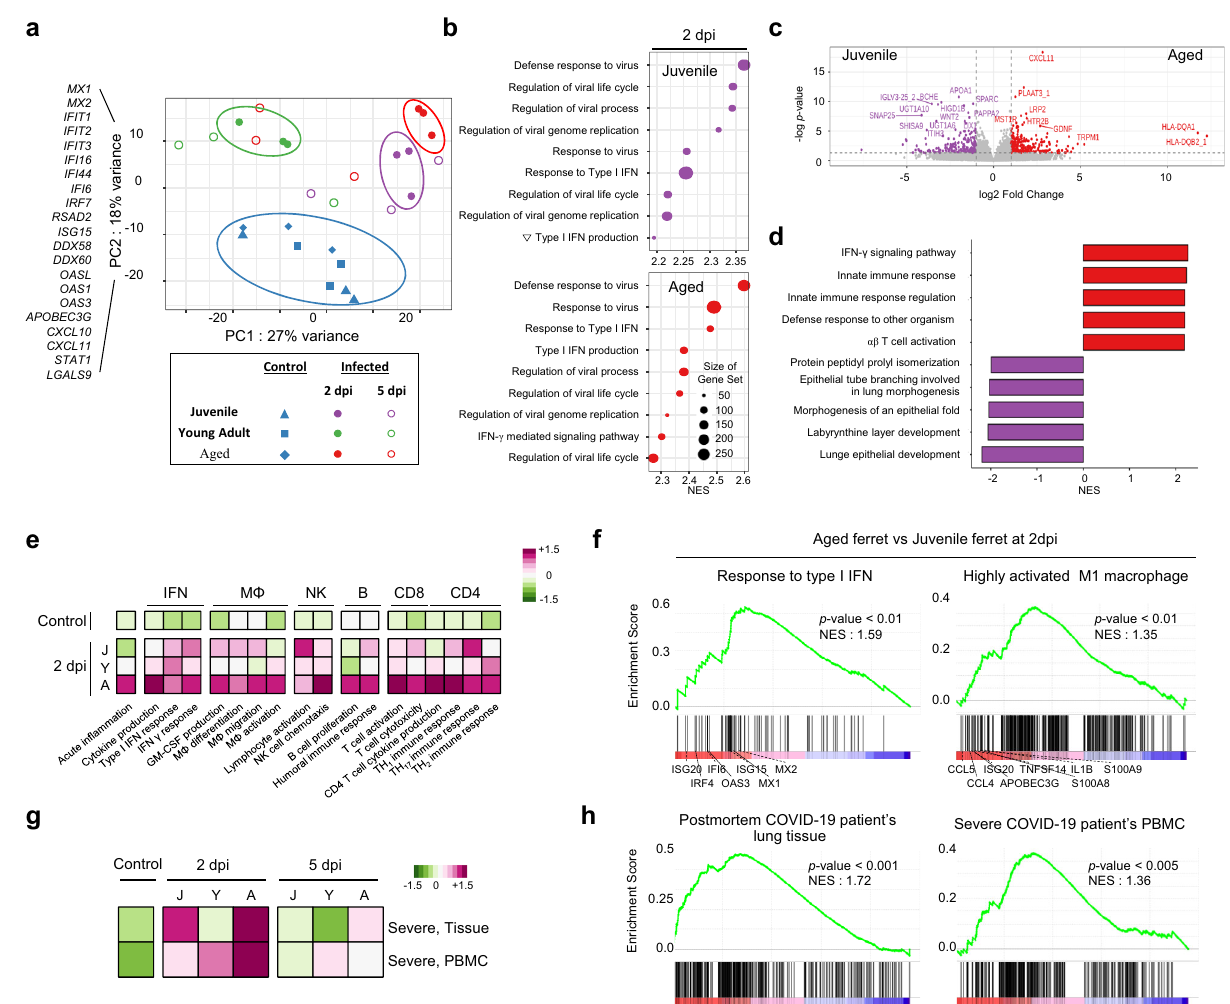
Fig. 6 Transcriptional pro fi le of immune-related genes in the lung of SARS-CoV-2-infected ferrets. a The overall variation of transcriptional pro fi les in the lung of SARS-CoV-2-infected ( n = 3/group) and age-matched uninfected (total n = 9) ferrets using principal component analysis (PCA). b The ‘ Common ’ gene sets were composed of genes differentially upregulated in more than two groups, while ‘ Juvenile-speci fi c ’ , ‘ Young adult-speci fi c ’ and ‘ Aged-speci fi c ’ gene sets were composed of genes uniquely upregulated in each group. Representative immune-related genes were listed next to the heatmap. Plots with normalized enrichment score (NES) from enrichment analysis of representative Gene Ontology (GO) biological pathway in juvenile and aged ferrets at 2 dpi, compared to age-matched control ferrets. c Volcano plots showing DEGs between juvenile and aged ferrets at 2 dpi. d Bar plots with NES from enrichment analysis of GO biological pathway in juvenile and aged ferrets at 2 dpi. e Heatmap of gene set variation analysis (GSVA) with immune-related GO biological pathway. J Juvenile, Y Young adult, A Aged. f Gene set enrichment analysis (GSEA) of gene sets related to type I IFN response and highly activated M1 macrophage between juvenile and aged ferrets at 2 dpi. The Y axis represents the enrichment score (ES), which re fl ects the degree to which a gene set is overrepresented at the top or bottom of a ranked list of genes, and the individual bar represents where the individual gene of each gene set is located in the ranked list of genes, corresponding to the projection of the gene set on the red-to-blue gradient, with red representing higher expression and blue representing lower expression ( f and h ). The p value of GSEA is the probability under the null distribution calculated by the one- sided permutation test (f: p = 0.0062, 0.0051 and h: p < 0.0001, 0.0025). GSVA and GSEA with indicated gene sets from severe COVID-19 patients between young adult and aged ferrets at 2 dpi. Control is the mean value ( n = 9) of juvenile, young adult, and aged control ferrets. Heatmap colors from green to magenta represent low to high enrichment, respectively. While changes in gene expression are conveyed using color gradation (green, light green, pink, and magenta), and unchanged expression is represented by white ( e and g ). Source data are provided as a Source Data fi